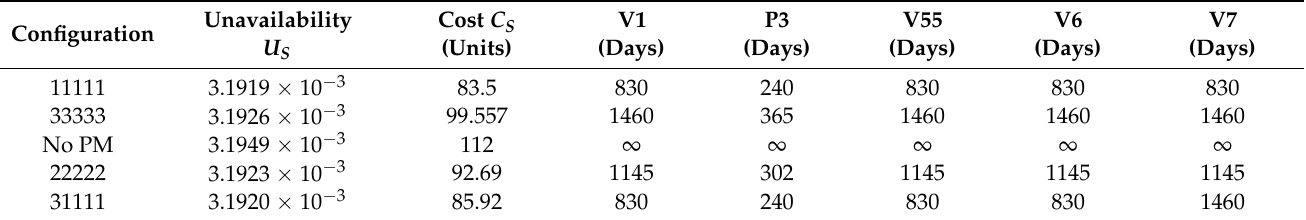
Table 2. Decision variable vectors ( TP 1 , . . . , TP k ) for the configurations of system Version